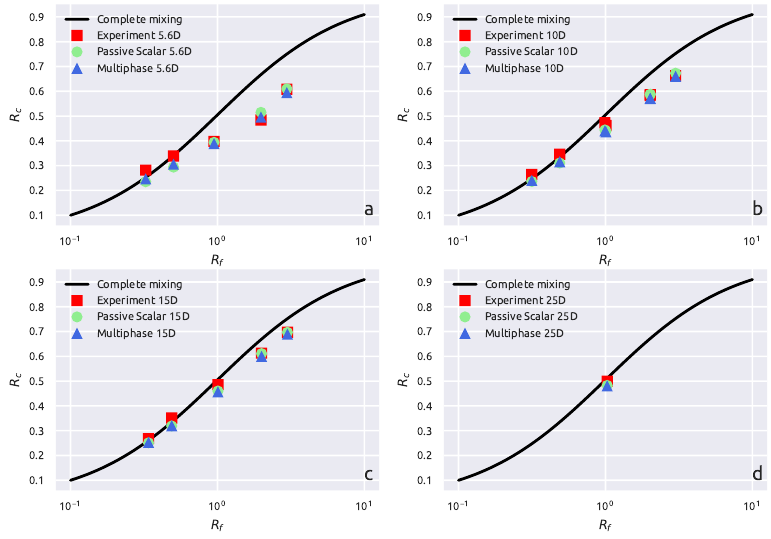
Figure 8. U pipe configuration - comparison of experimental results with passive scalar and multiphase model results for different Tee-junction distances: ( a ) 5.6D, ( b ) 10D, ( c ) 15D, ( d ) 25D.